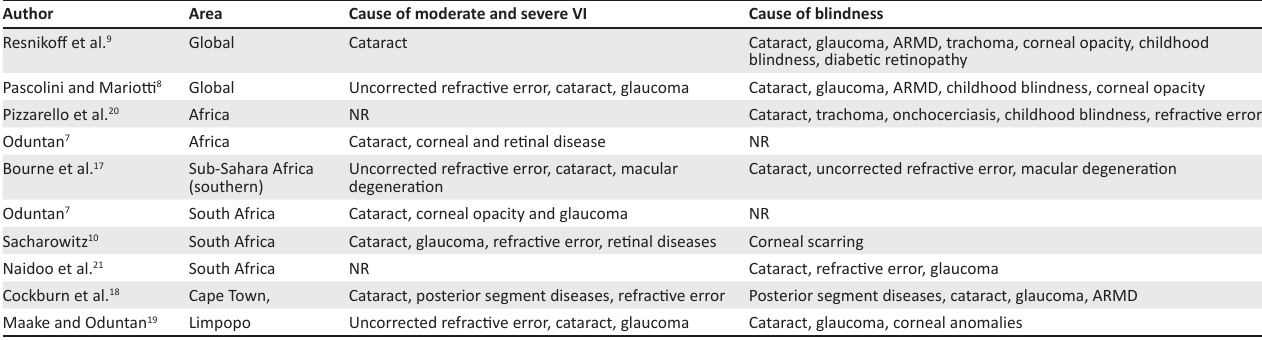
TABLE 3: Summary of studies reporting on the major causes of visual